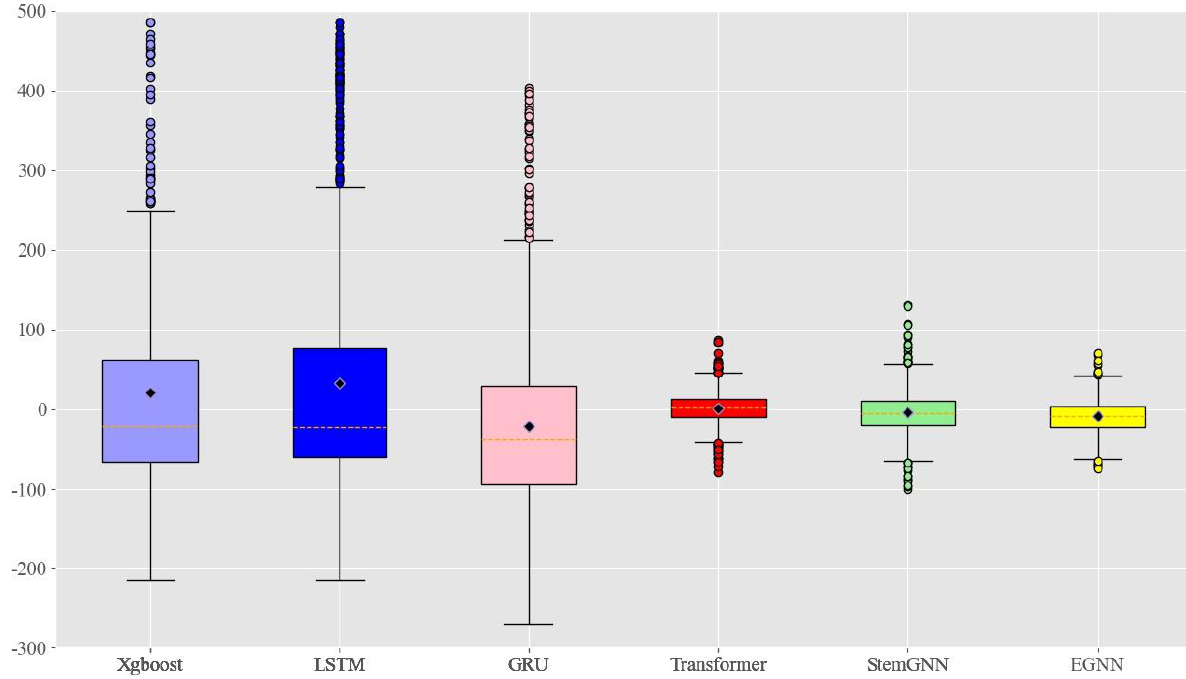
Figure 15. Boxplot of single time step prediction errors. Outliers indicate large forecast errors.